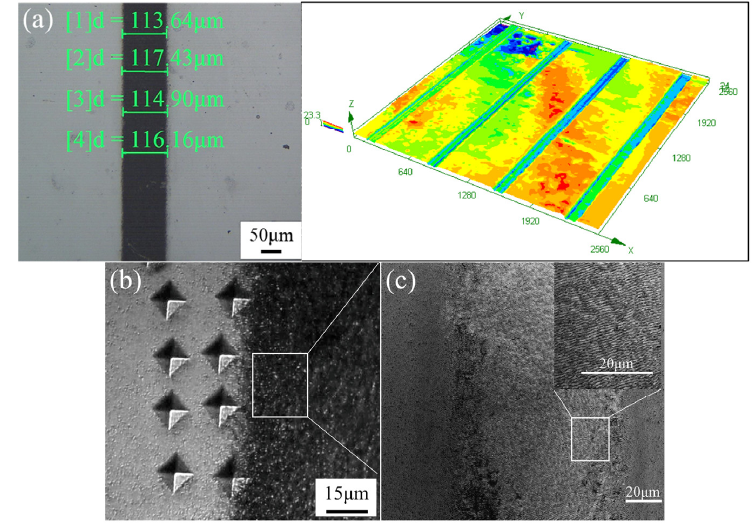
Figure 4. ( a ) The width of the groove textures. ( b ) The hardness of the edge of the groove textures. ( c ) The SEM images of the groove textures. In the process of groove texturing, there was a problem of groove formability, so the